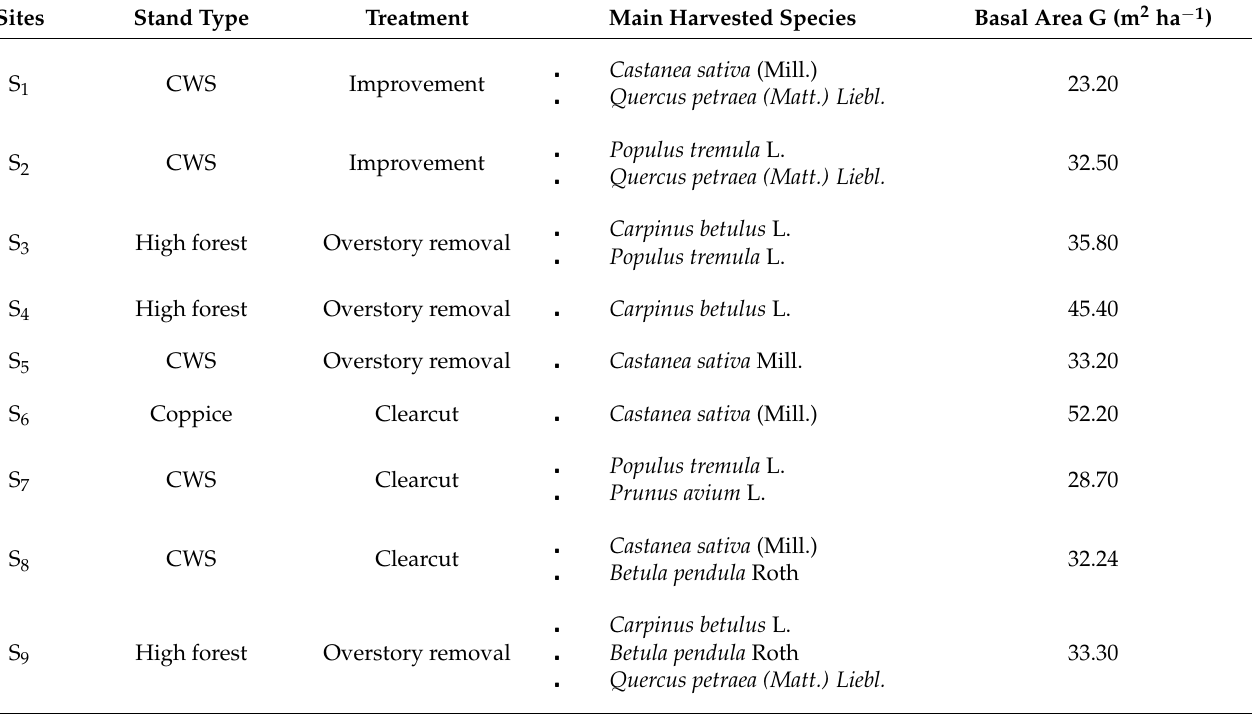
Table 1. Descriptive characteristics of the study sites. Presented are site number, stand type, treatment, main harvested species and basal area in m 2 ha −1 before the harvest. Sites